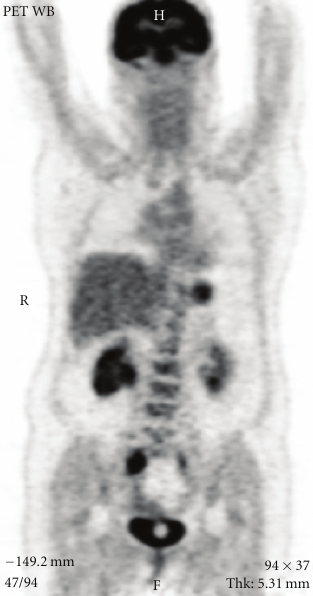
Figure 3: Pathological findings of the resected right ureter (Hematoxylin-eosin stain, × 20) As can be seen, two vessels (A) have thick fibrinoid deposits within their walls (B), sign of necrotic vasculitis. In the periphery, a dense polymorphous inflammatory infiltrate with polynuclear eosinophils (C) can be observed as well as